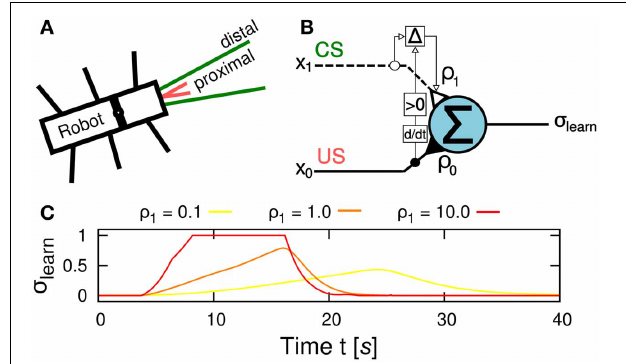
FIGURE 4 | Learning mechanism for insect-like, adaptive obstacle negotiation behavior. (A) Sensory signal setup of the robot with proximal and distal signal ranges. (B) Neural circuit of the input correlation (ICO) learning rule for correlation-based learning. The correlation (depicted by (cid:3) ) of an early, reflex signal x 0 ( t ) a late, predictive signal x 1 ( t ) alters the weight of the plastic synapse ρ 1 ( t ) according to Equation 3 while the synaptic weight ρ 0 is fixed. The output neuron applies a linear transfer function to generate the output signal σ learn . Note that the learning rule applies the positive time-derivative of x 0 to change the plastic synapse ρ 1 ( t ) . (C) Behavioral response to different values of ρ 1 . The ascent slope of the learner neuron output σ learn controlling the BJ increases proportional to the strength of ρ 1 , thus, the higher the value the faster and stronger the leaning motion takes place. Note that the behavioral output also alters the perceived sensory input such that a faster response leads to an earlier cut-off, i.e., when the robot leans beyond the edge of the obstacle. As a result, the time interval in which the BJ is active gets shortened.